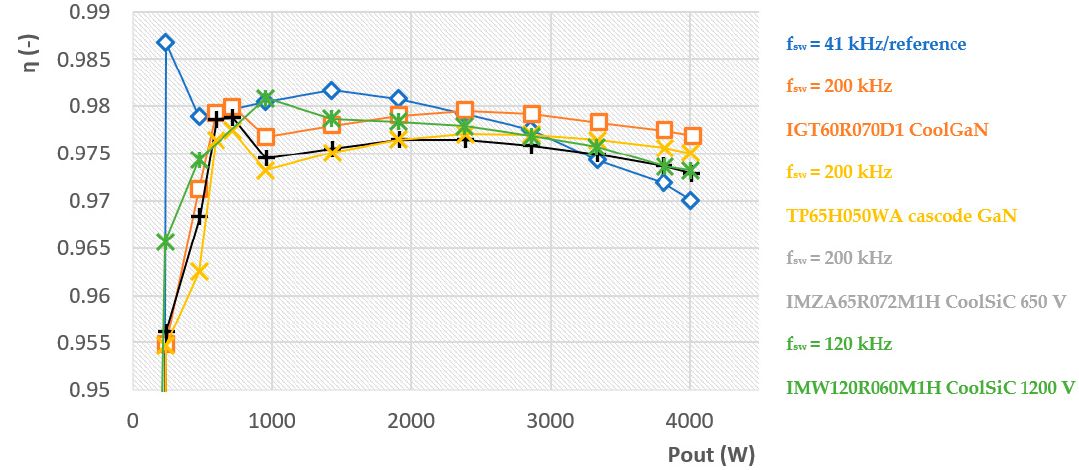
Figure 18. Final comparison of received results.